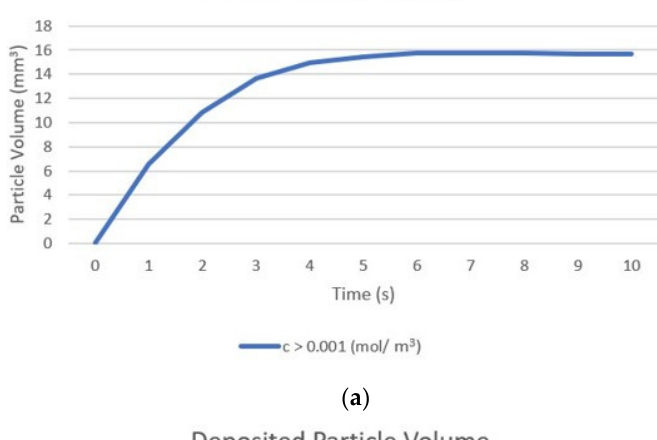
( d ) Figure 10. Concentration contours of uncharged nanoparticles within the fluid at; ( a ) 0 min, ( b ) 20 min, ( c ) 40 min, and ( d ) 60 min post-injection. Figure 11 shows the calculated volume of the nanoparticles within the fluid over time from the start of the injection to the end of the injection and the concentration of particles deposited onto cell surfaces until 10 s post-injection. This shows that the rate of increase in the particle volume within the fluid continually decreases until 7 s, then the volume remains constant until the end of the injection. The shape of the concentration profile is determined by the balance of the two main transport mechanisms: convection, and depo- sition. Close to the needle tip the convective velocity is sufficiently large to move particles away from the needle; as the fluid velocity declines the rate of deposition increases. The